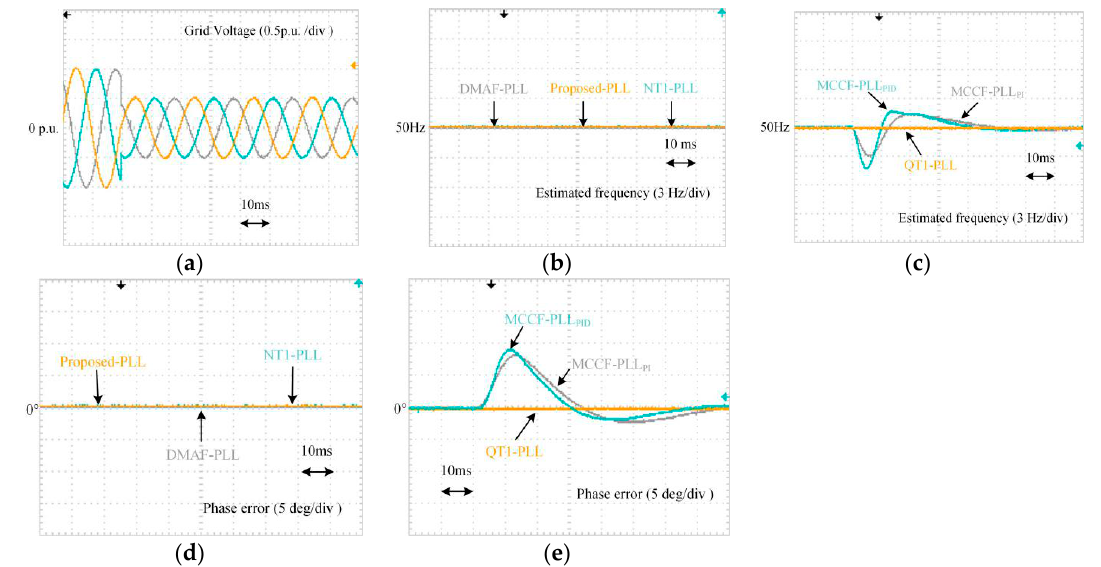
Figure 24. Experimental waveforms under a 0.5 p.u. voltage sag: ( a ) Three-phase voltages; ( b , c ) Estimated frequency; ( d , e ) Phase error.